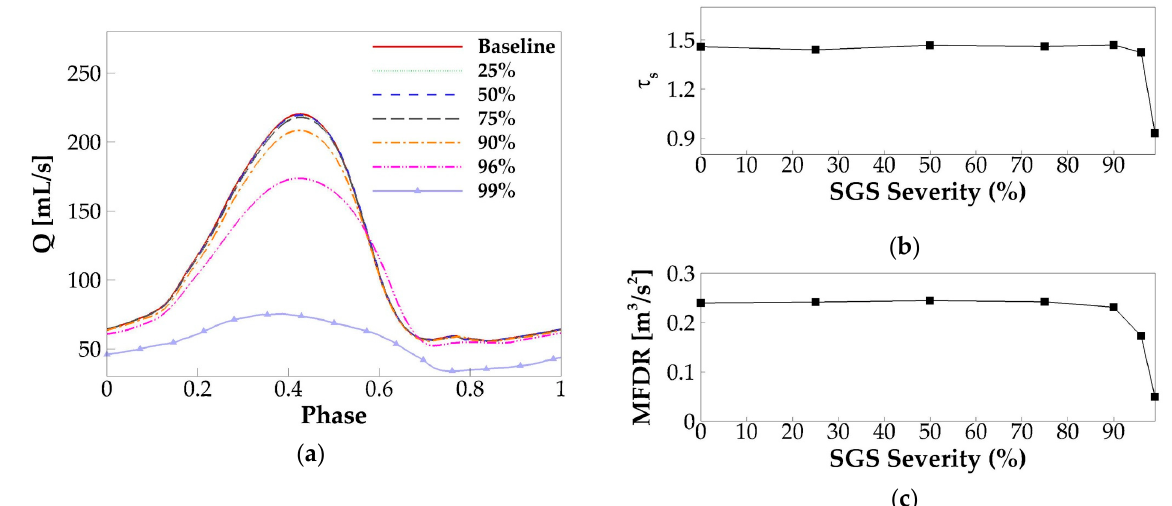
Figure 8. ( a ) The phase-averaged flow rate waveform in each case with the varied SGS severity. ( b ) The skewness quotient versus SGS severity. ( c ) The maximum flow deceleration rate (MFDR) versus SGS severity.